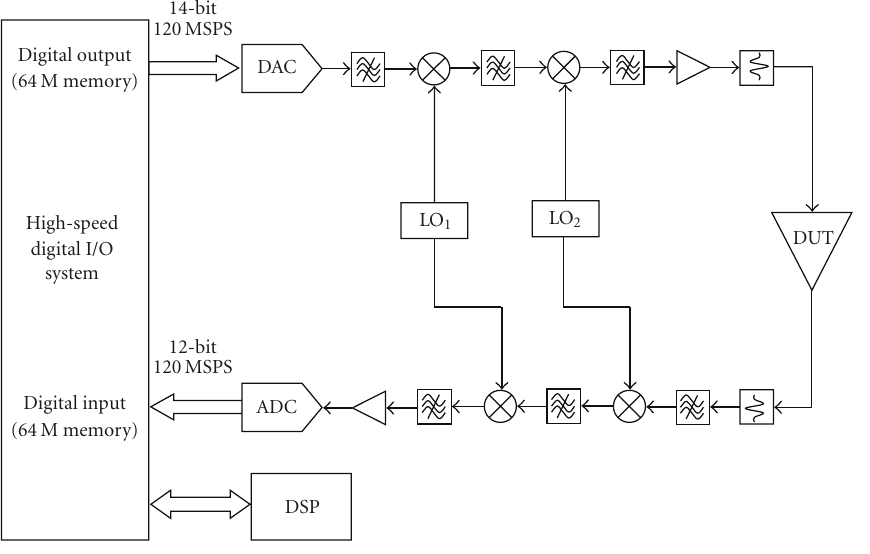
Figure 3: Block diagram of the